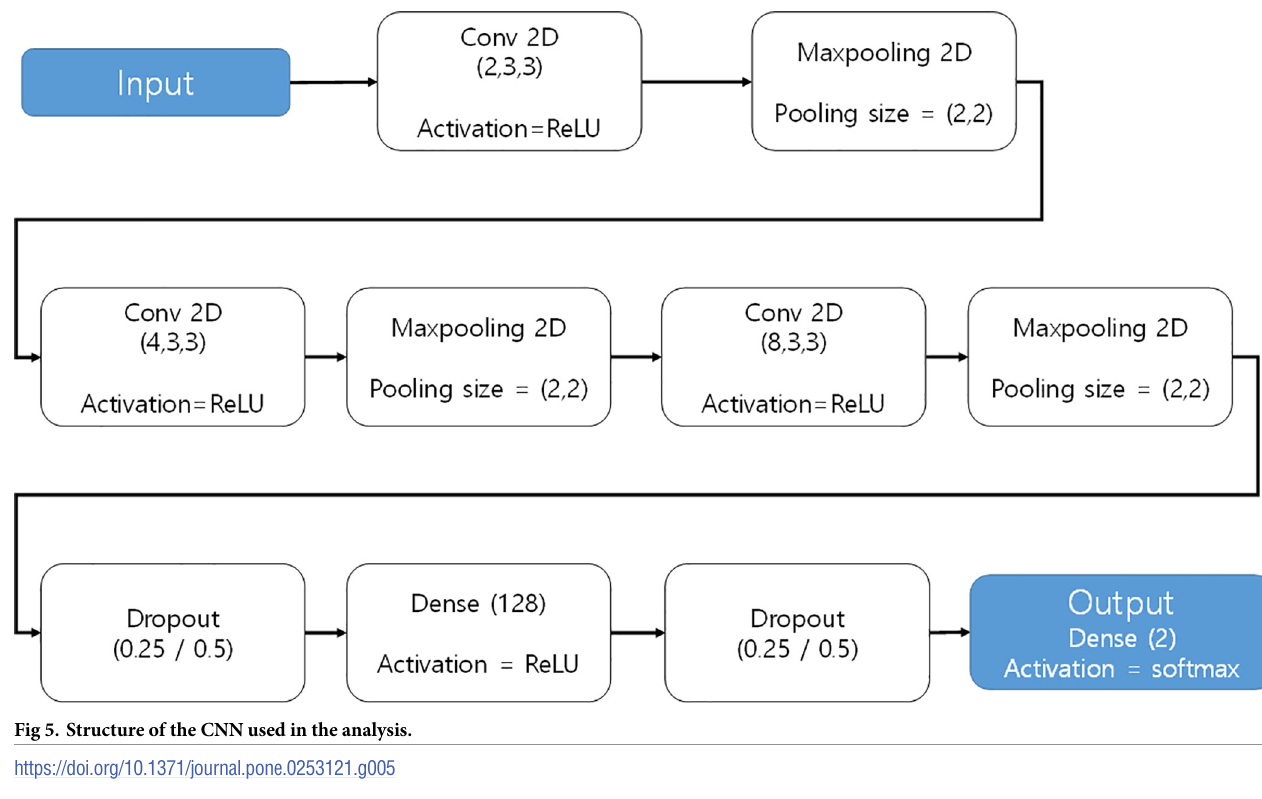
Fig 5. Structure of the CNN used in the